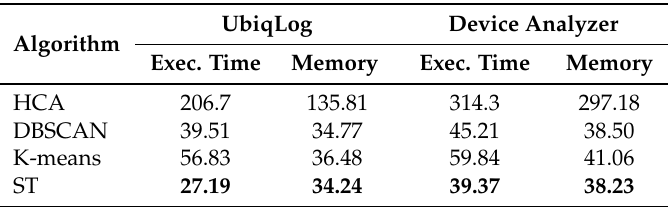
Table 4. Execution time (in seconds) and maximum used memory (in MB) comparison between our clustering algorithm ( ST) and other